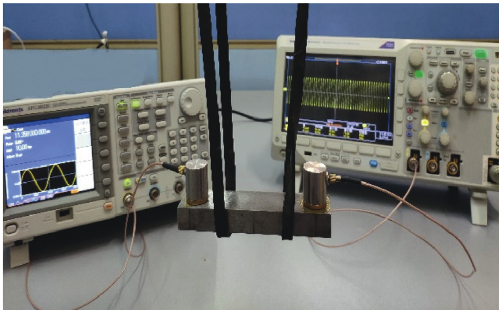
Figure 5: Harmonic excitation detection